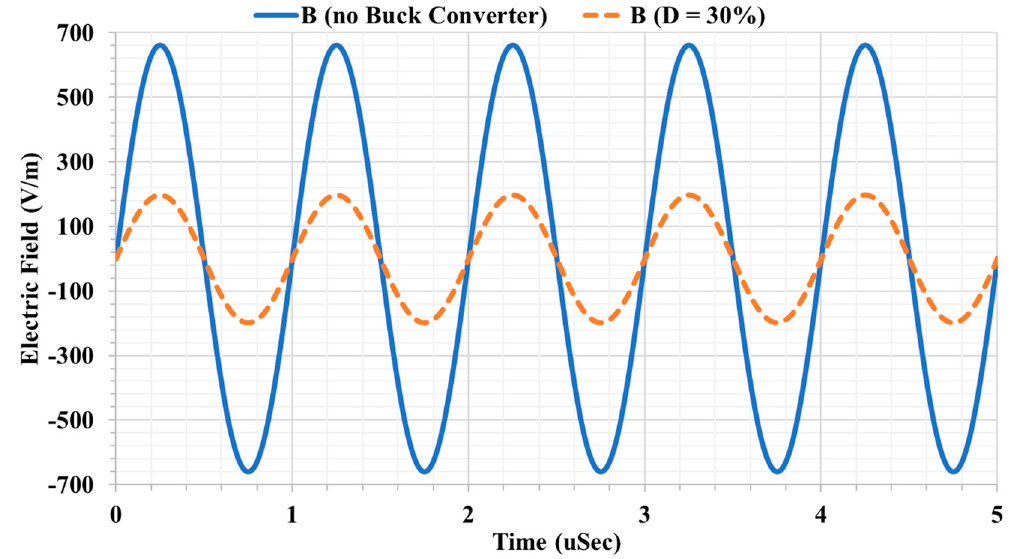
Figure 11. Simulated electric field at measurement point B in front of Tx1 and Rx1.